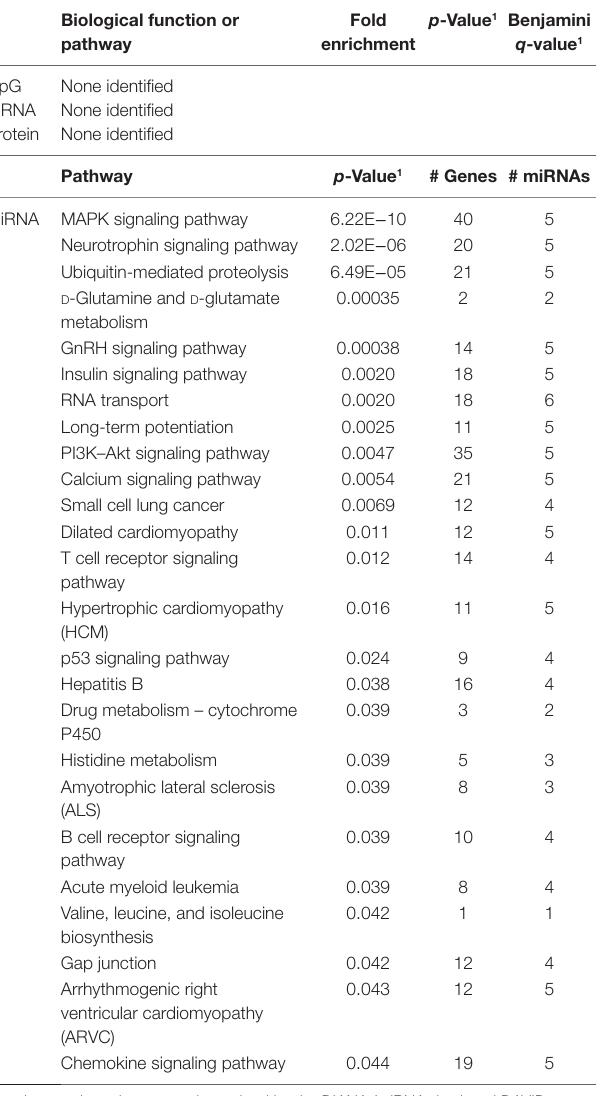
TaBle 3 | Biological functions correlated with TerT. TaBle 4 | Biological functions correlated with